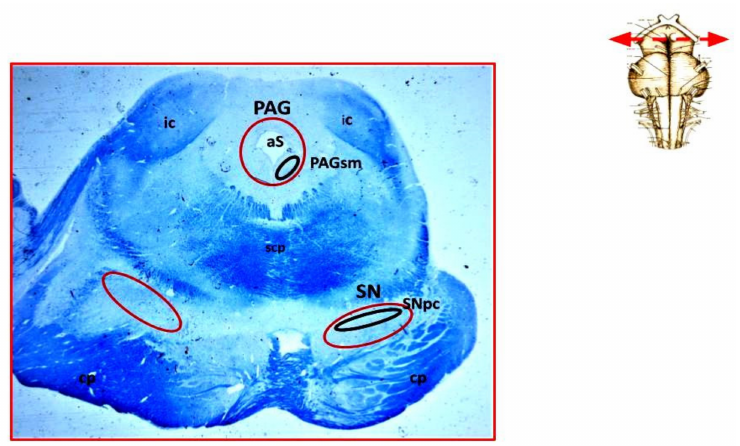
Figure 1. Photomicrograph of a transverse section of midbrain at the inferior colliculus level (at the top right, indication of the level corresponding to the section). The circled red area higher up, around the Sylvius aqueduct, indicates the location of the PAG; inside, circled in black, the location of the subnucleus medialis is represented; The bilateral circled areas lower in red indicate the localization of the substantia nigra; inside, the black circle circumscribes the pars compacta. Klüver-Barrera stain. Original magnification, 0.5 × ; aS = aqueduct of Sylvius; cp = cerebral peduncle; ic = inferior colliculus; PAG = periaqueductal gray; scpd = superior cerebellar peduncle decussation; PAGsm = periaqueductal gray subnucleus medialis; SN = substantia nigra; SNpc= substantia nigra pars compacta.